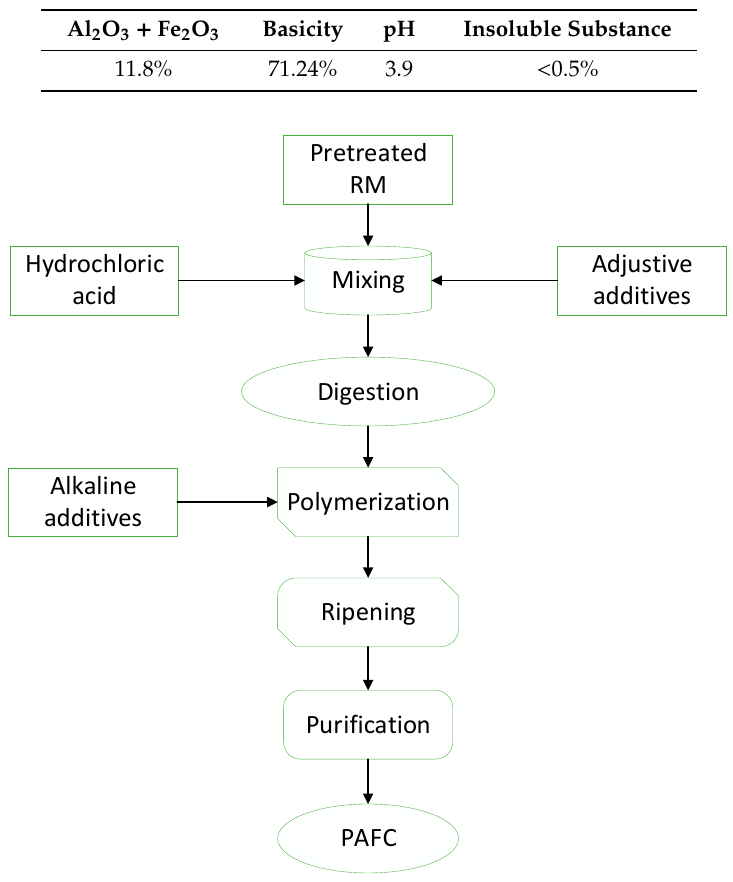
Figure 14. Production process of RM PAFC [126].